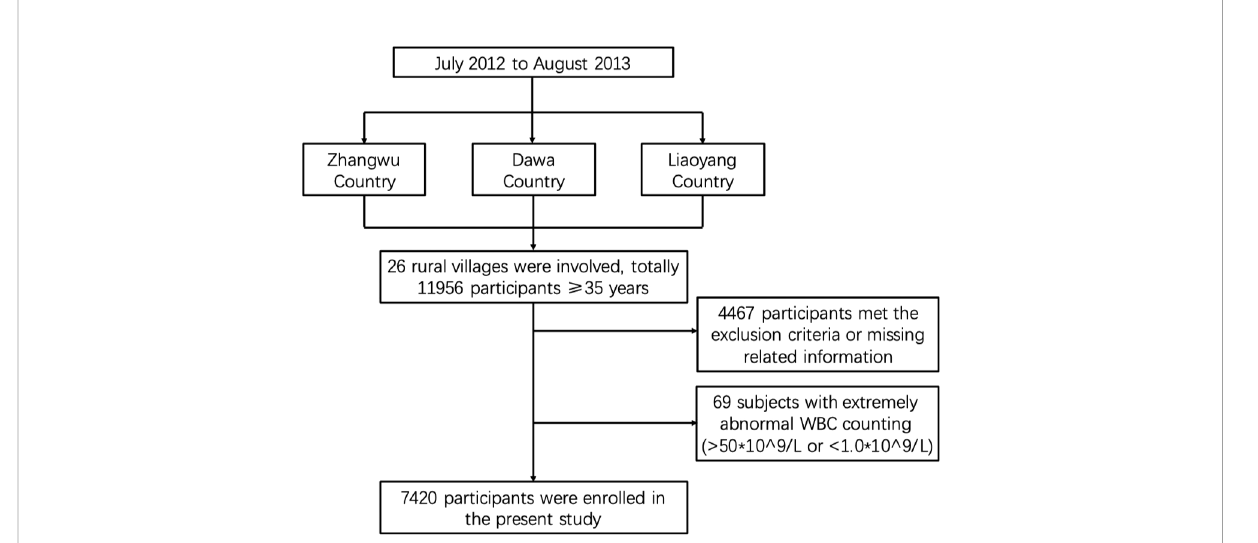
FIGURE 1 Flowchart of our selected study population protocol. We randomly selected 26 villages from three countries in northeastern China from July 2012 to August 2013. In total, 11,956 participants were enrolled in our study. After excluding people who did not meet the research criteria, such as those with cancer, pregnancy, and missing related information, and further excluding 69 subjects with extremely abnormal WBC counts, we fi nally got a study population of 7,420